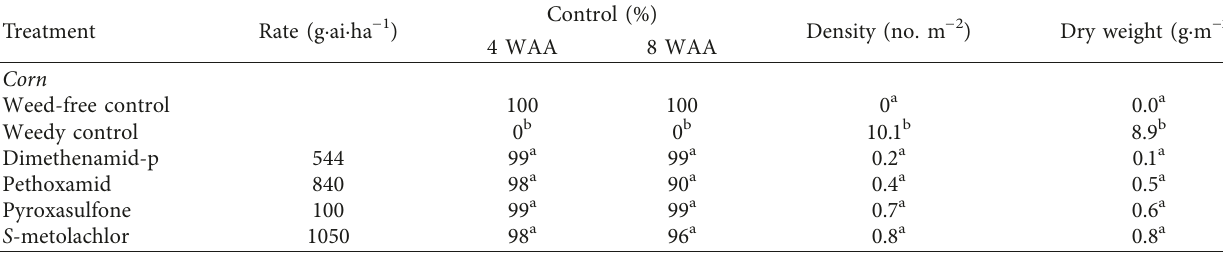
Table 2: Control, density, and dry weight of redroot pigweed in corn treated with VLCFA inhibitor herbicides, applied preemergence (PRE), near Exeter in 2016 and 2017 and Ridgetown in 2017 a .